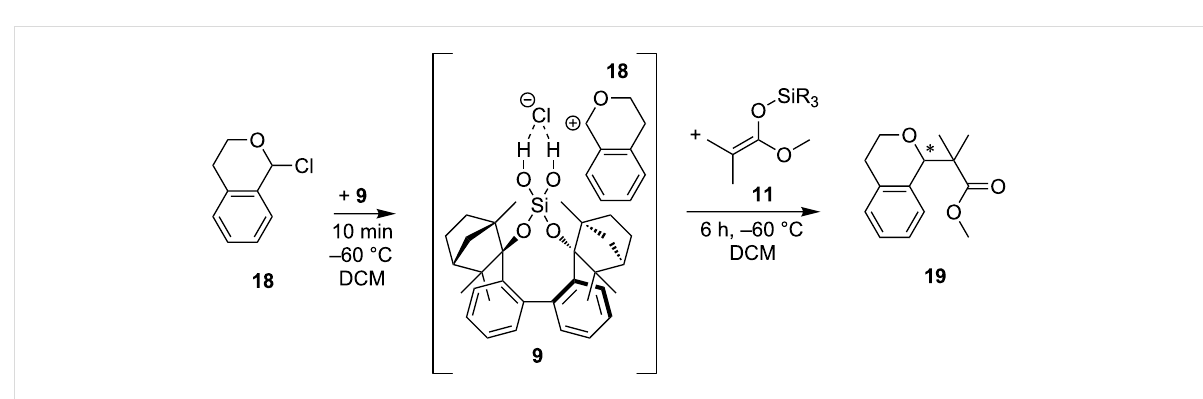
Table 10, entry 9). The yield decreases as the